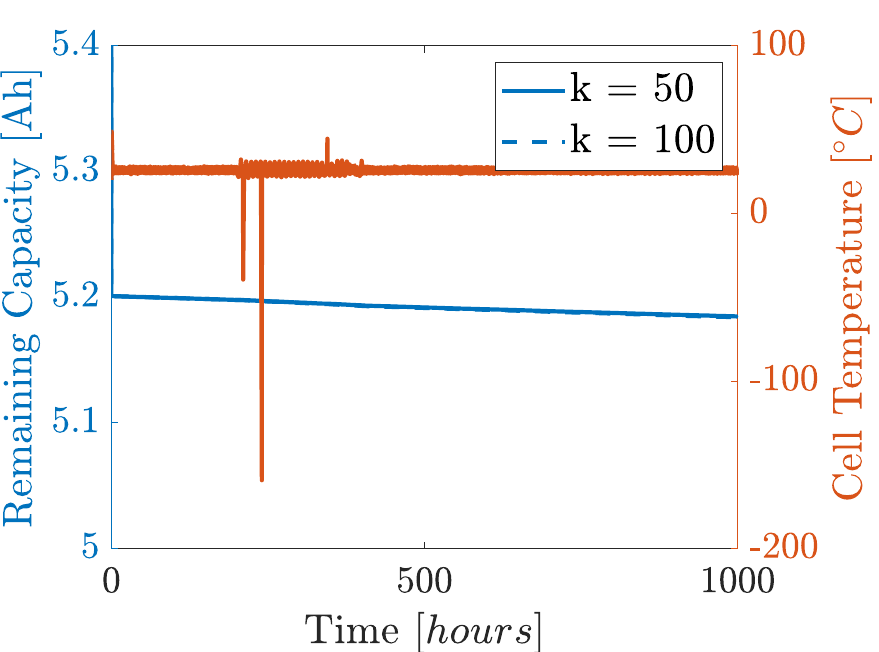
Figure 15. Advanced SoC: Effect of the gain k on Battery 3.